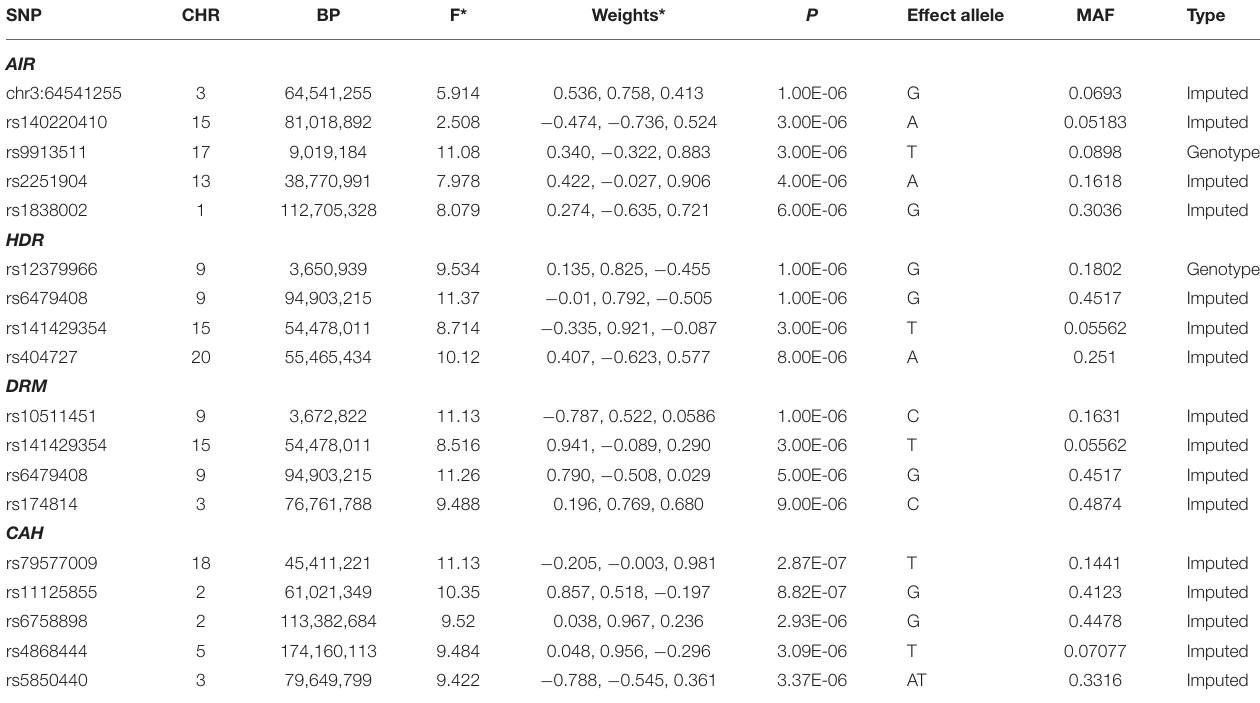
* F-Statistic tests the significance of the canonical correlations. * Weights reflect the correlation coefficients for each individual trait. Tooth Agenesis, impaction and Rotation (AIR); Hypoplasia, displacement and rotation (HDR); Displacement, Rotation and Mamelon (DRM); and Dental caries, Agenesis and Hypoplasia (CAH).